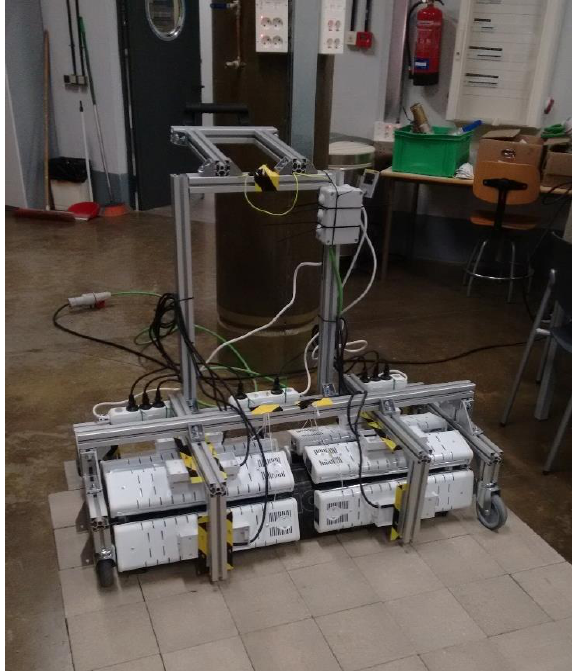
Figure 19. Prototype used in the laboratory.